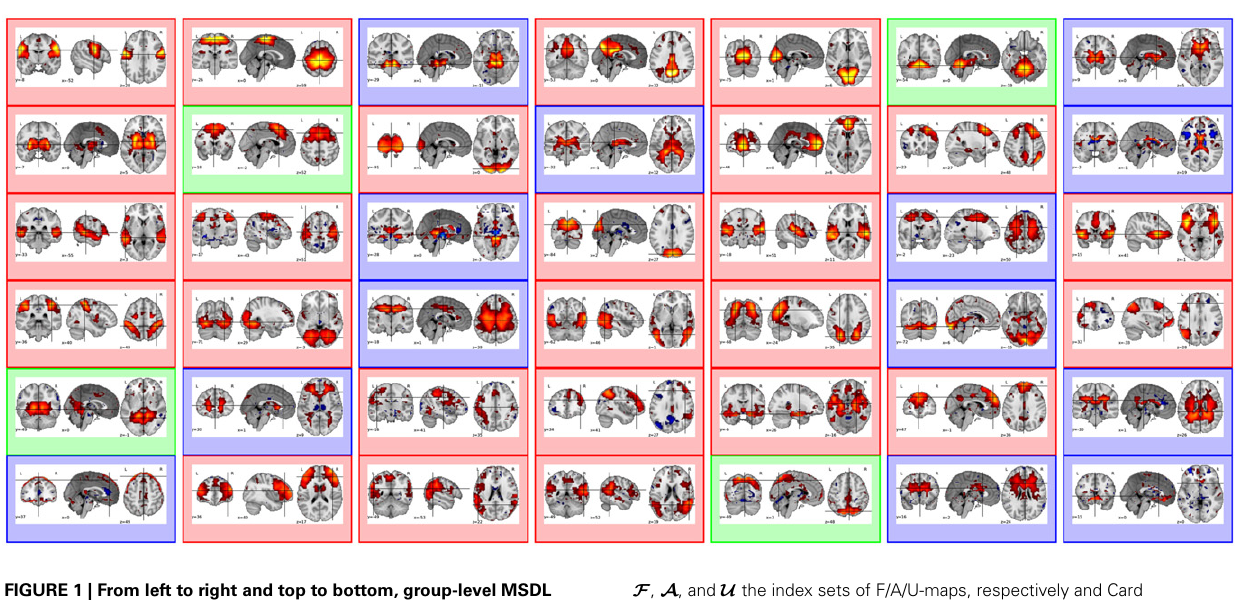
F , A , and U the index sets of F/A/U-maps, respectively and Card ( F ) = 25, Card ( A ) = 13, and Card ( U ) = 4 their respective size. Each map v k consists of loading parameters within the ( − 1, 1) range where positive and negative values are depicted by the hot and cold parts of the color